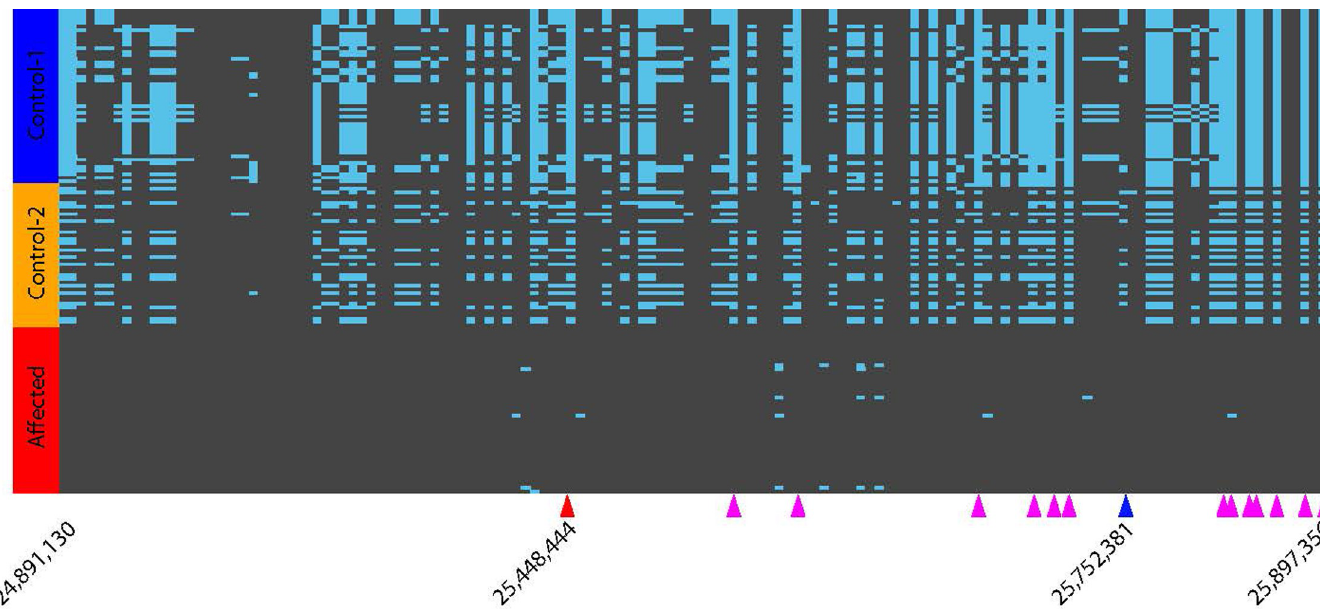
Fig 2. Haplotypes near the marker on CFA18 that are significantly associated with Early Onset Adult Deafness (EOAD) in Rhodesian Ridgebacks. Random subsets of control dogs were selected for visualization purpose: Control-1 dogs (blue) do not carry any of the EOAD-associated haplotypes, whereas Control-2 dogs (orange) carry one copy of the EOAD-associated haplotype (i.e., a carrier). Affected dogs are indicated in red. Rows correspond to haplotypes (two rows/individual), and columns correspond to markers. The positions of the first and last markers are 24,891,130 and 25,897,356, respectively. The most significant marker in the GWAS is indicated by a red triangle (position 25,448,444). The marker closest to the 12-bp deletion is indicated by a blue triangle (position 25,752,381). Magenta triangles indicate markers where Control-1 dogs are homozygous for a reference allele and affected dogs are homozygous for an alternate allele. These 13 informative markers, along with the most significant marker (red triangle) are used for defining a core haplotype predictive of EOAD in Rhodesian Ridgebacks. Positions of the informative markers are 25545949, 25557090, 25660957, 25696066, 25704136, 25708602, 25857995, 25861018, 25862585, 25863350, 25863894, 25883389, and 25897356. The genome coordinates in canFam3.